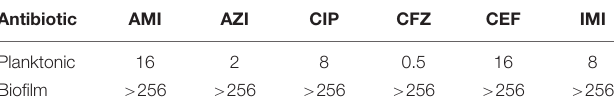
TABLE 1 | Minimal inhibitory concentrations (MICs) of a variety of antibiotics against planktonically- and biofilm-grown Mabs NJH12 in synthetic CF medium.